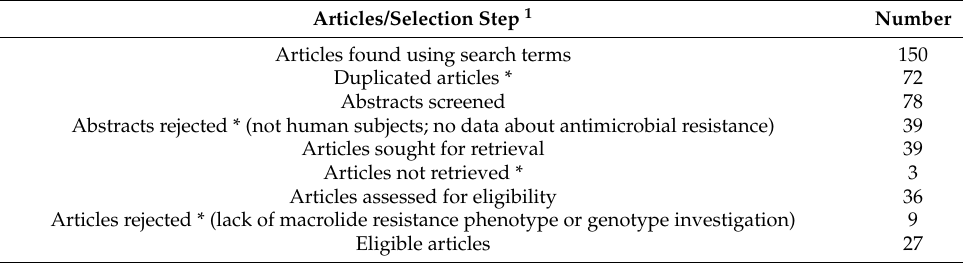
Table 2. Published articles in Lilacs and PubMed databases and selection